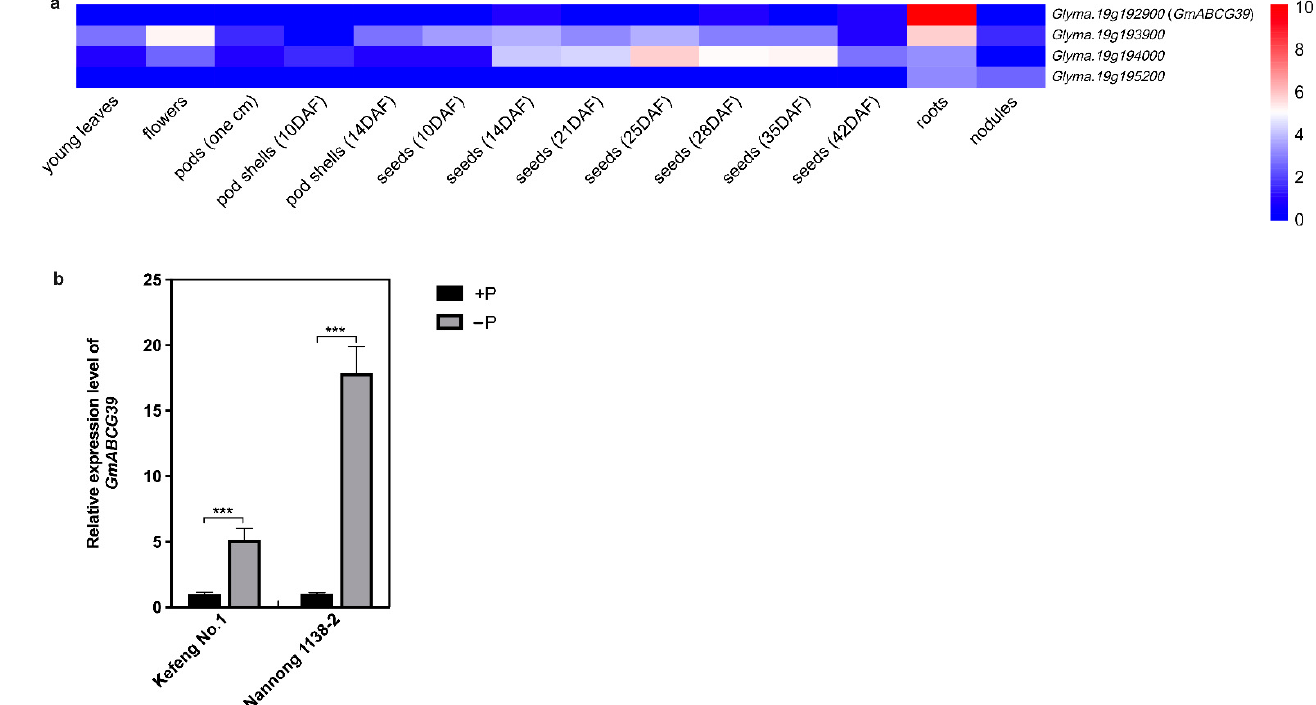
Figure 3. Expression profile of candidate genes. ( a ) Expression profile of four candidate P-efficiency- related genes in different soybean tissues. ( b ) Induced expression analysis of GmABCG39 in “Kefeng No.1” and “Nannong 1138-2” under low-P stress. “Kefeng No.1”: the low-P-tolerant accession; “Nannong 1138-2”: the low-P-sensitive accession; +P: treatment including 1/2 Hoagland solution with 0.5 mM KH 2 PO 4 ; − P: treatment including 1/2 Hoagland solution with 0.5 mM KCl; DAF: days after flowering; ***: significance at the 0.001 probability level (Student’s t -test).